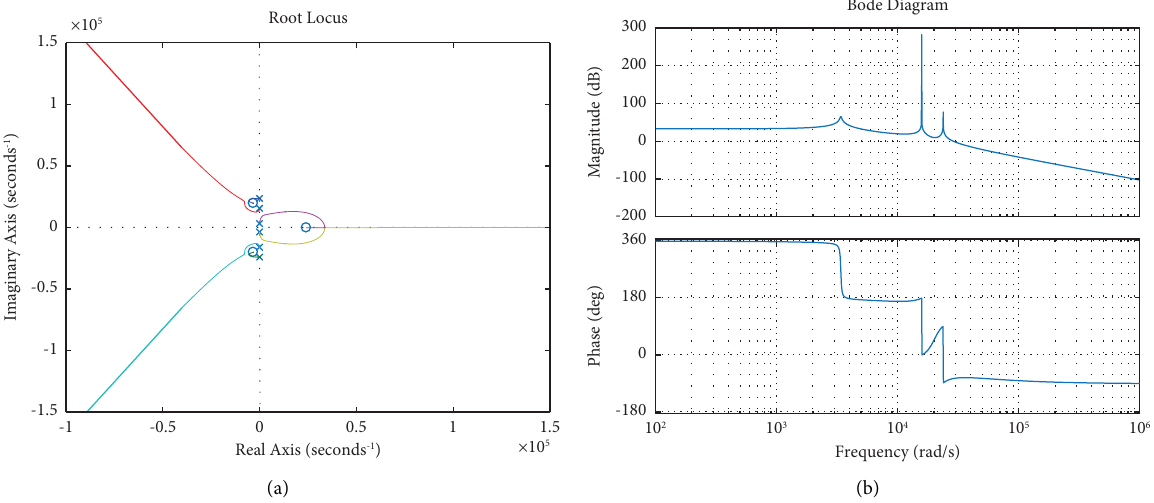
Figure 9: For LC flter: (a) root locus; (b) bode.